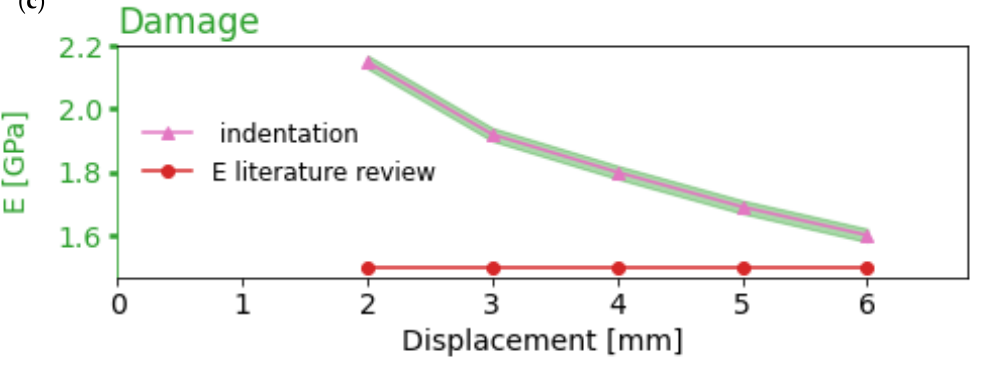
Figure 2. Five single-loading indentation tests at five different penetration depths ( a ), unloading segments ( b ), and degradation of Young’s modulus ( c ).